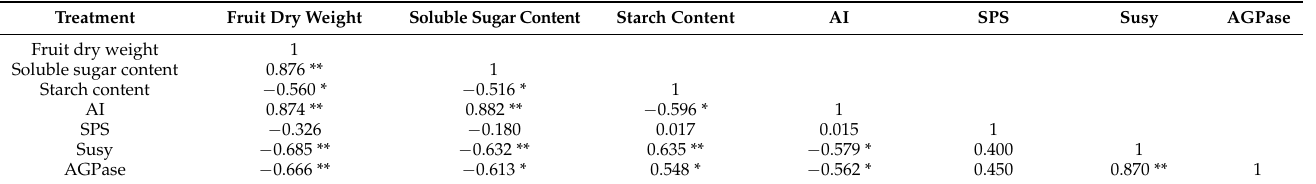
Table 8. Pearson’s correlation coefficients among the carbohydrate contents and the activities of carbohydrate enzymes in tomato fruit during experimental periods.